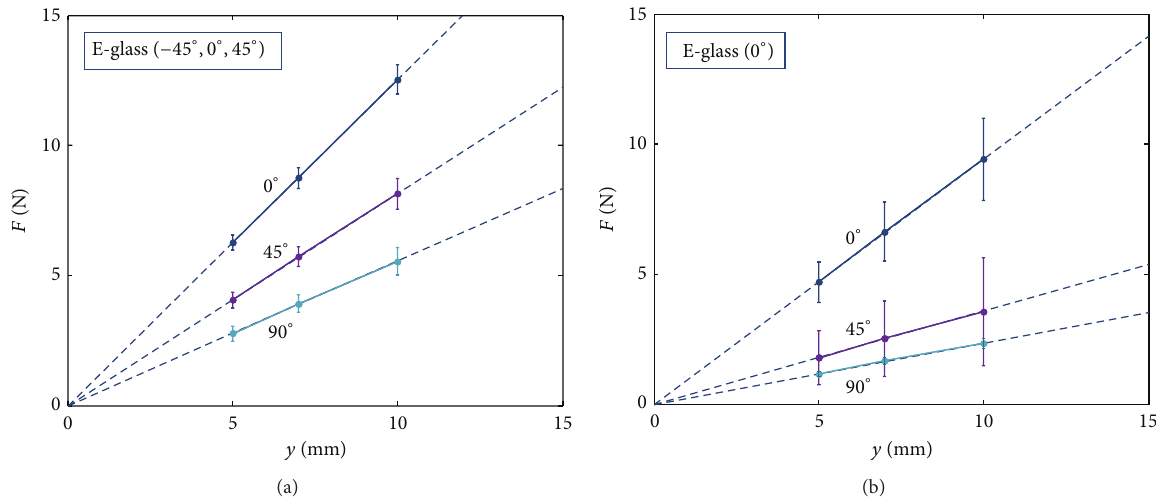
Figure 8: The force-displacement relation of the fiberglass composite strips made by the E-glass (− 45 ∘ , 0 ∘ , 45 ∘ ) in (a) and the E-glass ( 0 ∘ ) in (b).